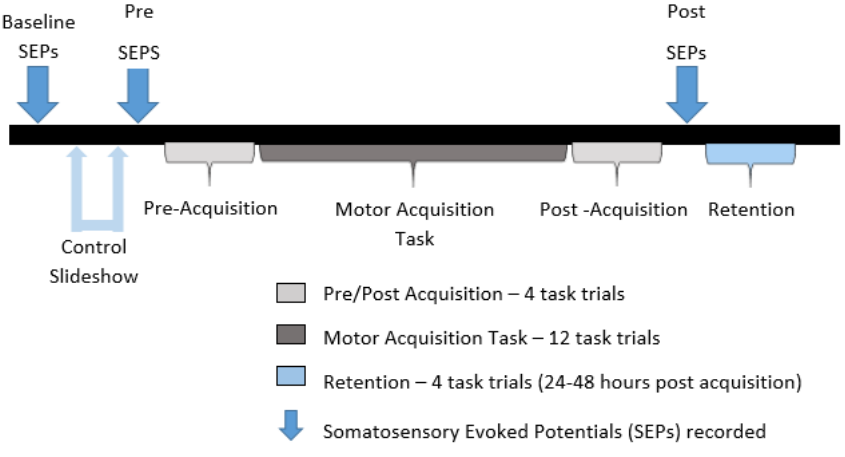
Figure 3. Experimental procedure.